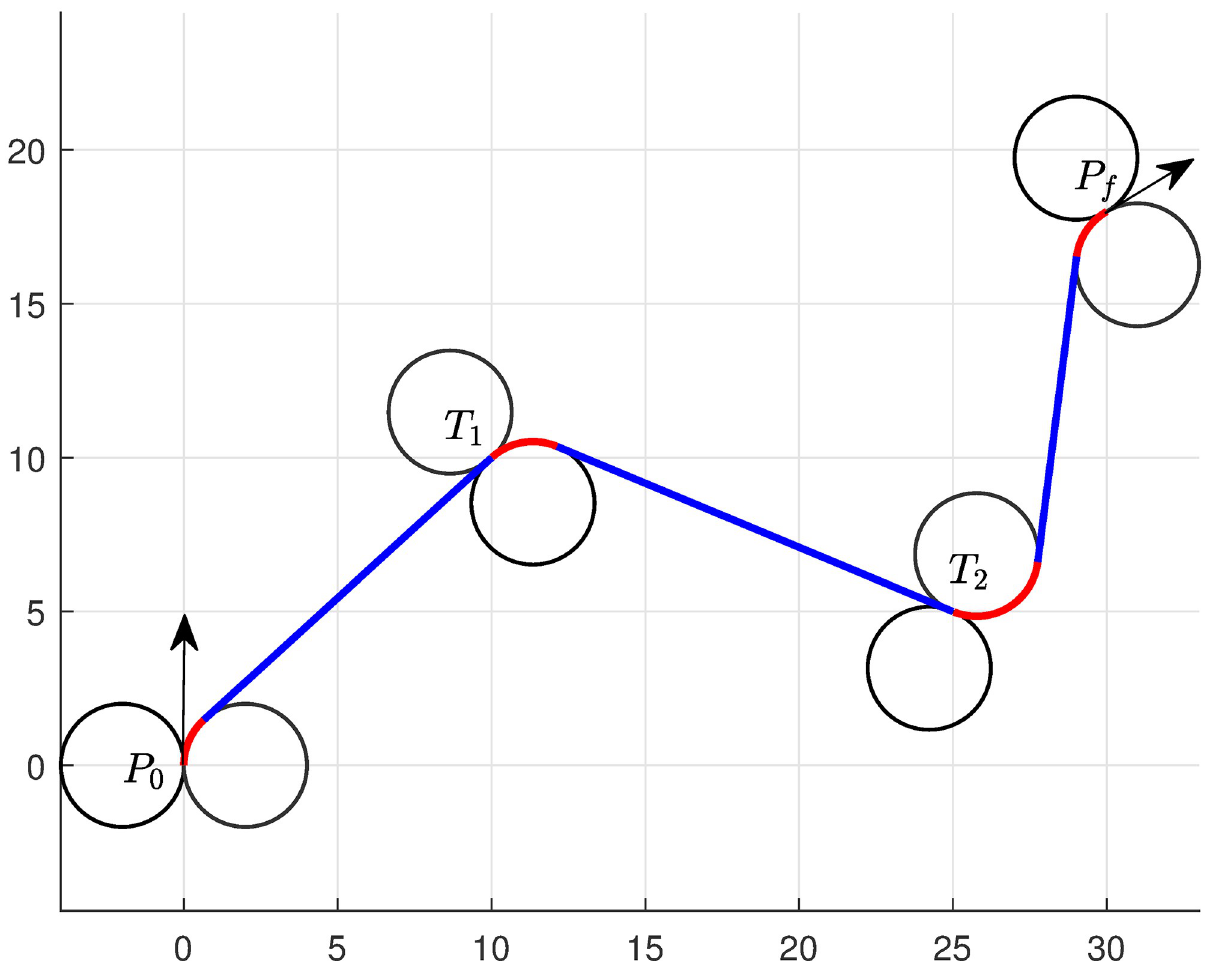
Fig 4. Minimum path of UAV with two targets touring of type RSRSLSR.